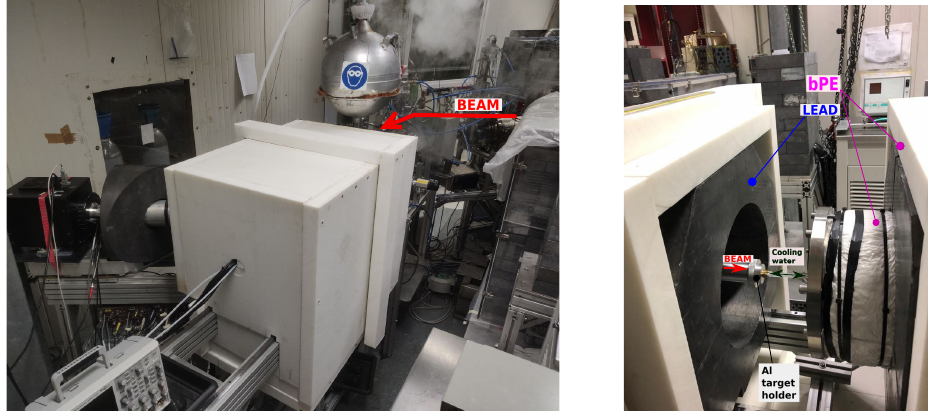
Figure 1: Present setup for the 17 O(p, γ ) 18 F cross section measurement at LUNA. Left: the external borated Polyethylene shielding. Right: the three-layer shielding opened to show the aluminum chamber and target holder to which the water cooling is connected. Part of the BGO detector is also visible inside the shielding.